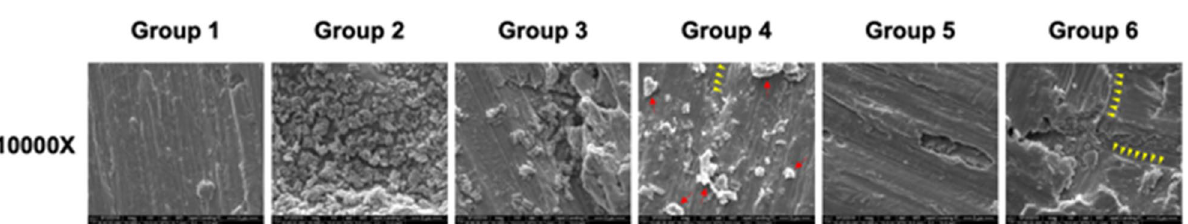
Figure 3. Scanning electron microscope images of titanium discs after various treatments (Group 1–Group 6) at magnifications of × 10,000. The red arrow represents titanium particles. The yellow arrow represents scratches caused by